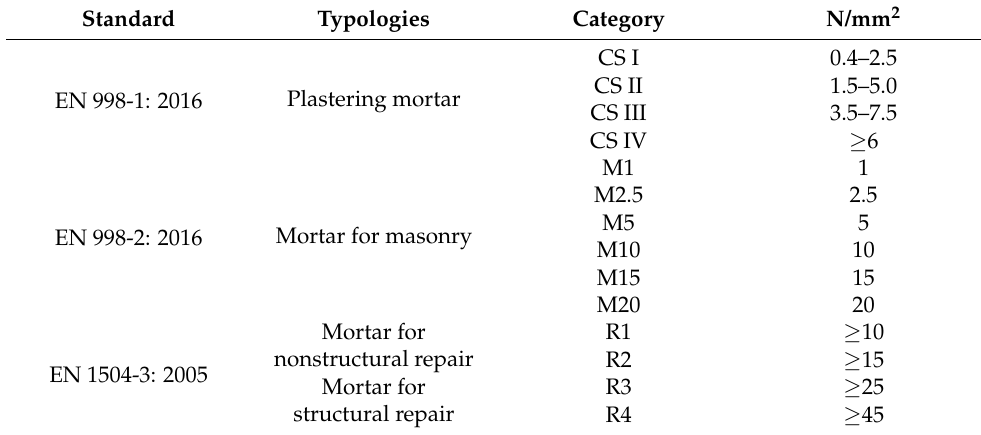
Table 4. Comparative table between data in the literature and data obtained with experimentation, with medium indirect tensile strength (1) and medium compressive strength (2).